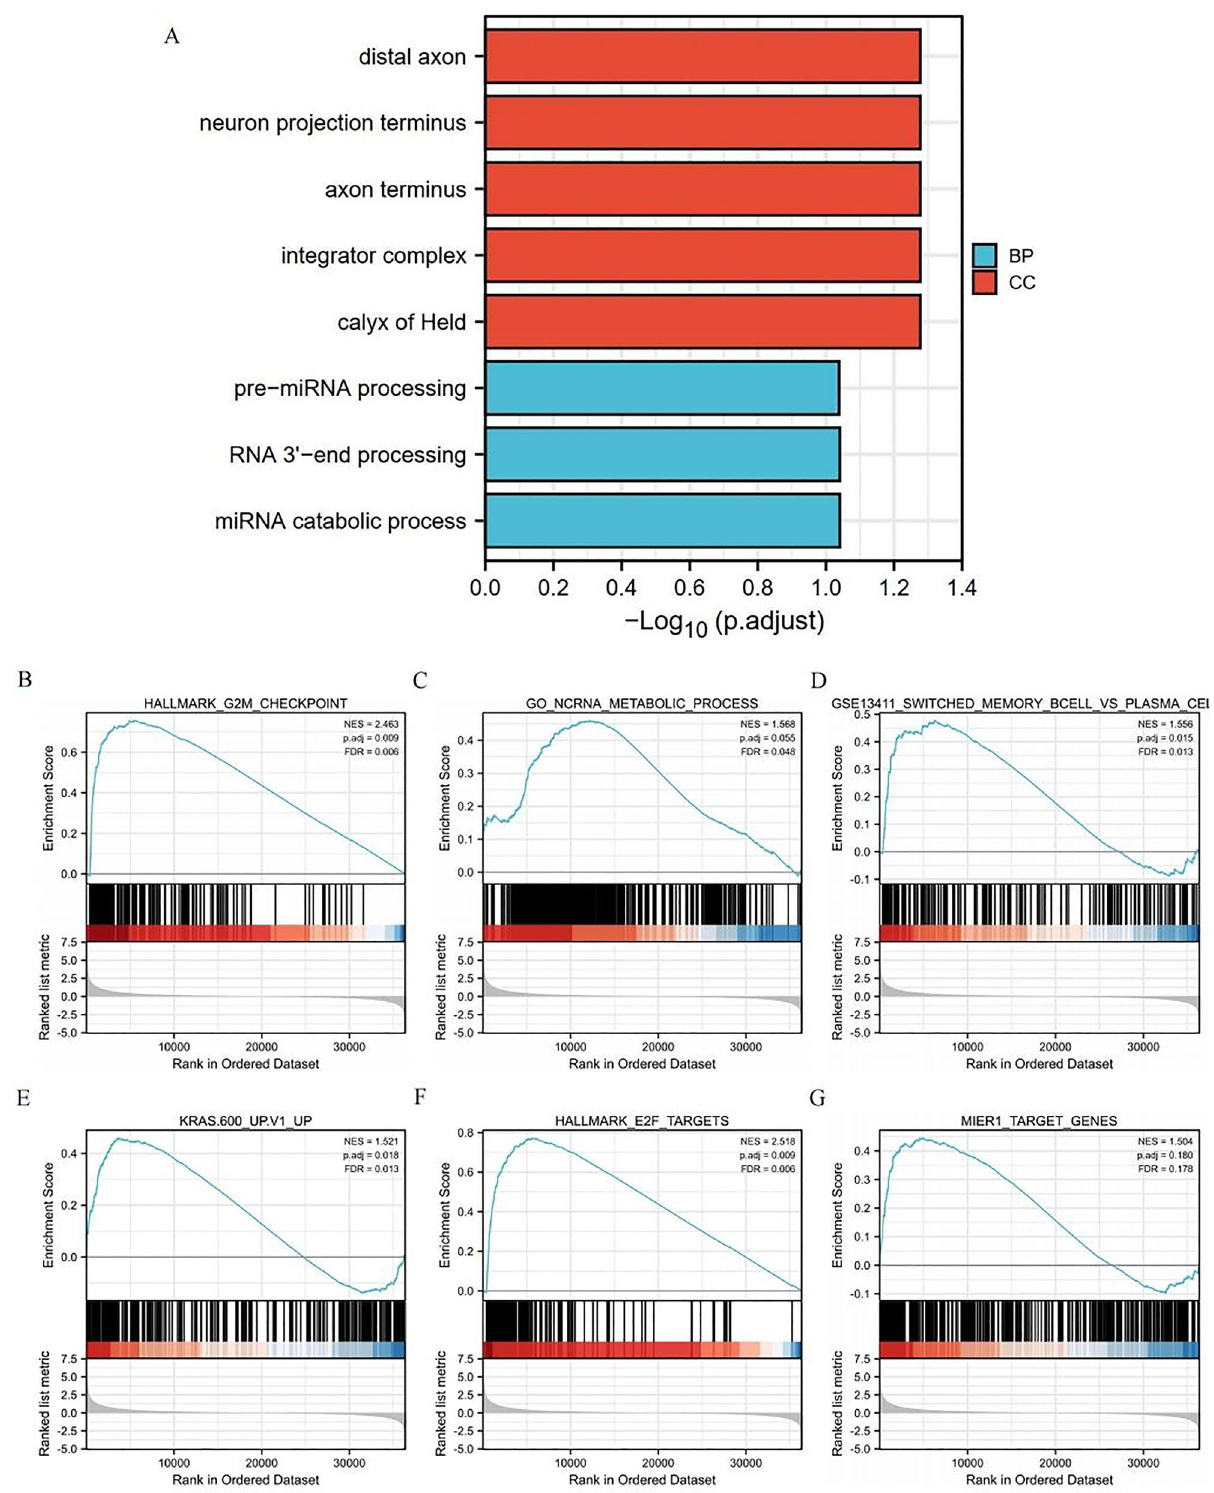
Figure 2. Significantly enriched GO annotations of NCAPH related genes in LUAD. ( A ) Top 8 of biological process enrichment related to NCAPH related genes with bar graph. ( B )–( G ) Enrichment plots from the gene set enrichment analysis (GSEA). Several pathways and biological processes were deferentially enriched in NCAPH-related LUAD including G2M checkpoint, ncRNA metabolic process, memory B cells, KRAS signaling, E2F targets and MIER1 pathway. BP, biological processes; CC, cellular